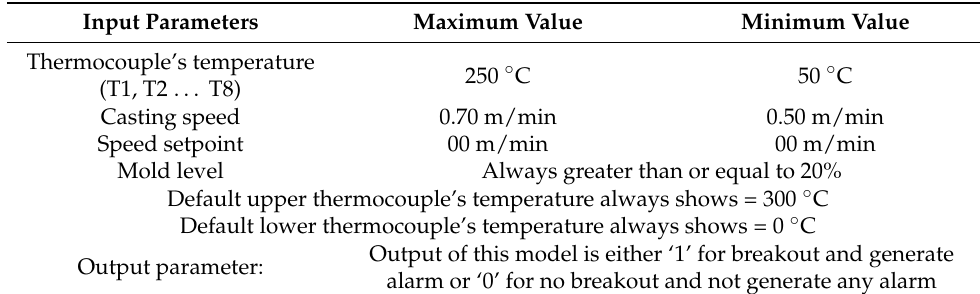
Table 2. Basic parameters of the model.